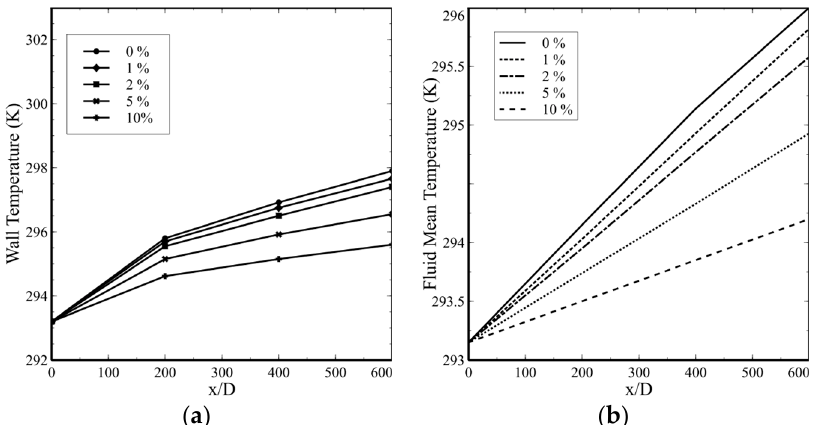
Figure 13. Effect of nanoparticle concentration in tube flow: ( a ) axial development of wall temperatures; ( b ) fluid mean temperatures for Al 2 O 3 -water.